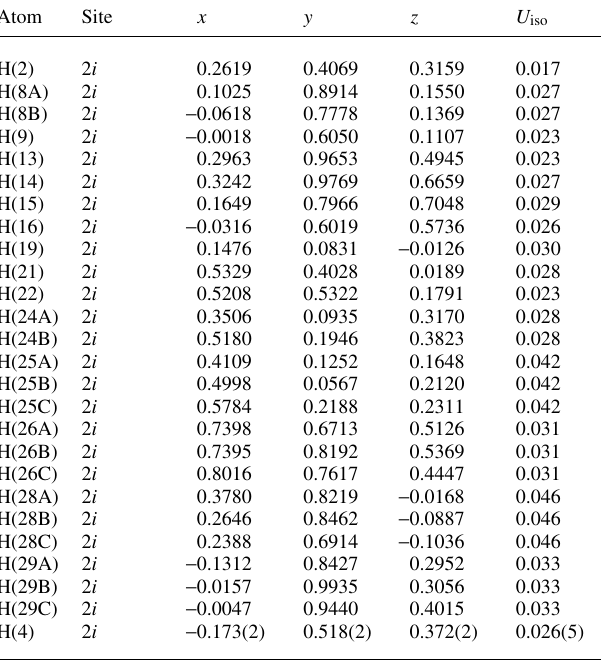
Table 2. Atomic coordinates and displacement parameters (in Å 2 )